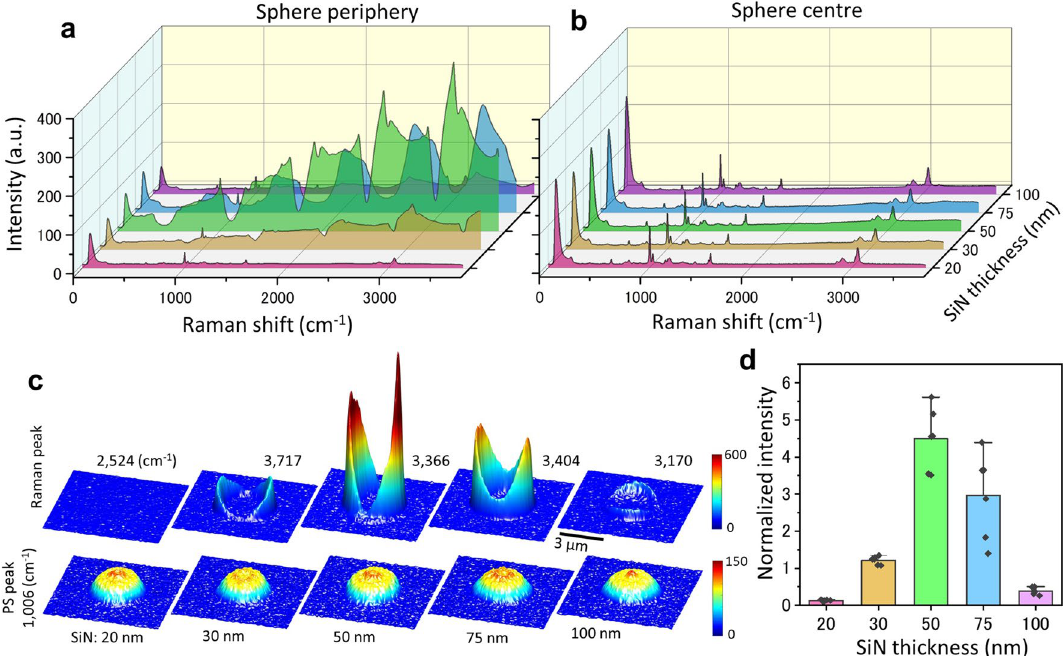
Figure 3. Relationship between SiN thickness and the intensity of the sphere’s circumferential light. ( a ) The average Raman spectra of the circumference of the 3 μm diameter PS spheres with a SiN thickness of 20–100 nm. The circumferential light was most intense with the SiN film of 50 nm thickness but hardly detectable with a SiN film of 20 or 100 nm thickness. ( b ) Average Raman spectrum at the sphere centre. The same PS spectra were seen for all the SiN film thicknesses. ( c ) Pseudo-3D colour maps of the PS peaks and the anomalous Raman peaks for SiN thicknesses of 20–100 nm. The maps of the PS peak showed a similar dome- like shape for all SiN thicknesses (bottom row). With the anomalous Raman peaks, the ring shape around the spheres was clearly observed at the SiN thicknesses of 50 and 75 nm (top row). ( d ) Relationship between the anomalous Raman peaks and SiN thickness. Six spheres were measured at each SiN thickness and the ratios of the maximum anomalous Raman intensity to that of the PS peak (1006 cm −1 ) at the sphere centre were calculated and normalised. The normalized intensity of the Raman spectrum was obtained by normalizing the maximum Raman intensity around the PS sphere at the PS peak (1006 cm −1 ) at the centre of the sphere. The mean values of normalized intensity from 20 to 100 nm thickness are 0.13, 1.22, 4.49, 2.97 and 0.38 respectively. Standard deviations are 0.018, 0.109, 0.846, 1.158 and 0.097. Anomalous Raman intensity had a maximum at 50 nm SiN thickness but was reduced when the SiN thickness was increased or decreased. Scale bar, 3 μm in ( c